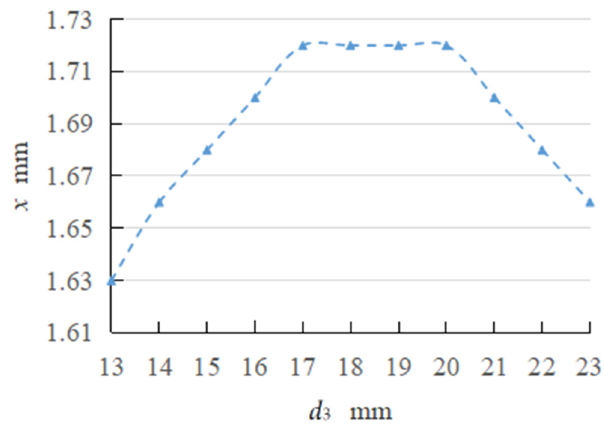
Figure 8. Relationship between d 3 and x.